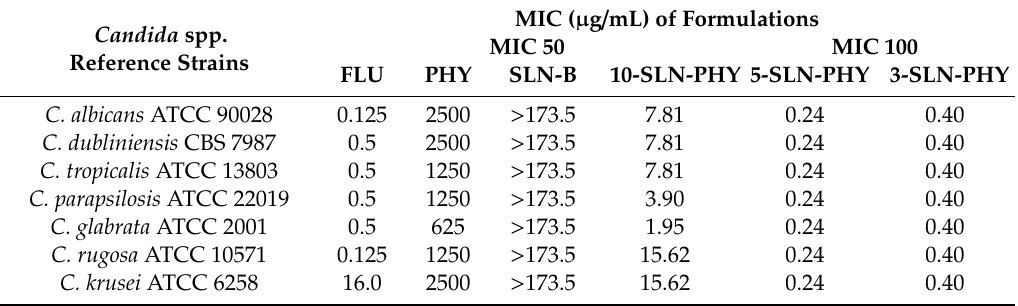
Table 2. Minimum inhibitory concentration values of phytol and SLN against Candida spp. reference strains determined with the broth microdilution